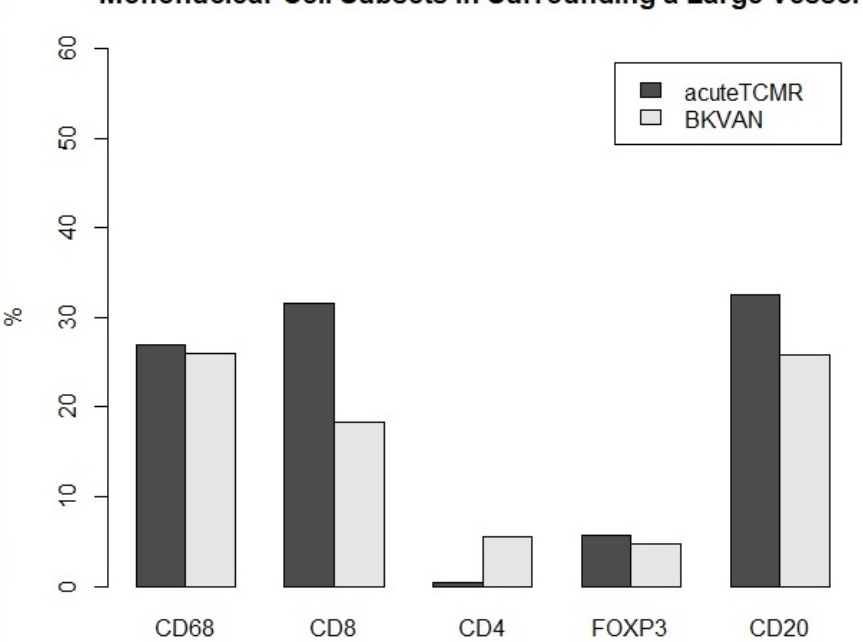
Figure 7. The proportions of mononuclear cell subsets in acute TCMR versus BKVAN cases in the surrounding a large vessel ROI.